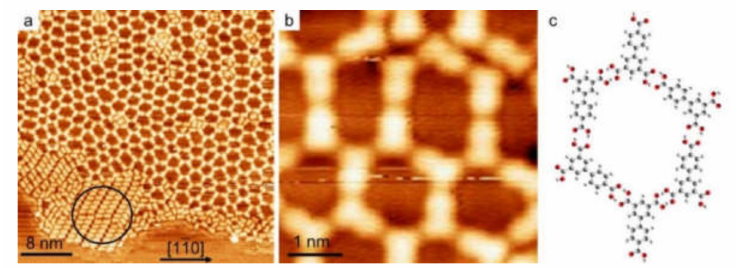
Figure 1. A mixture of H0 networks and CP1 structures at 293 K (room temperature). ( a ) An STM overview ( U = − 1.2 V, I = 50 pA). The oval indicates the close-packing structure, CP1. ( b ) The enlarged view of H0 networks. ( c ) A tentative structural model of an H0 cavity. Color: C, grey; O, red; H,